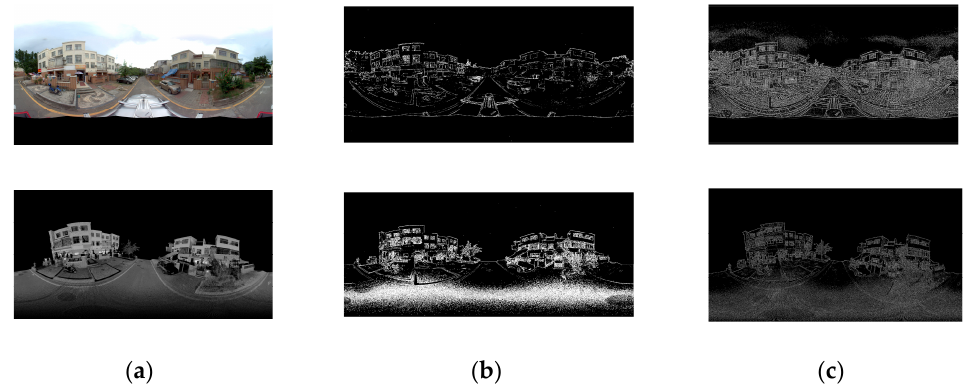
Figure 2. Comparison of phase congruency with Sobel edge detection. ( a ) Original images; ( b ) Sobel edge detection; ( c ) phase congruency.